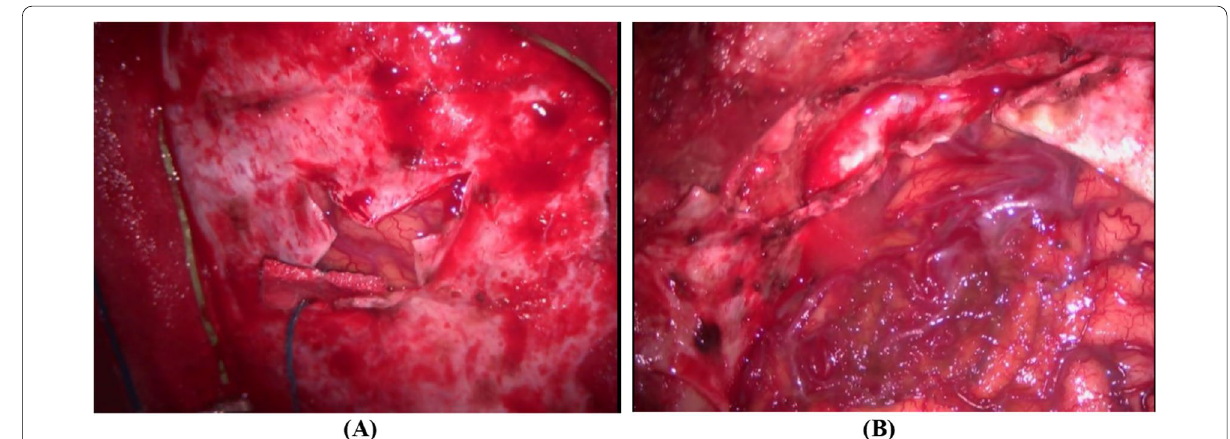
Fig. 8 Intra‑operative microscopic image: A dural incision B AVM